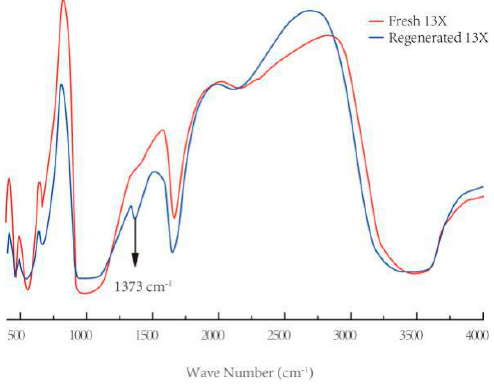
Figure 8. FTIR spectra of fresh and regenerated 13X zeolite.